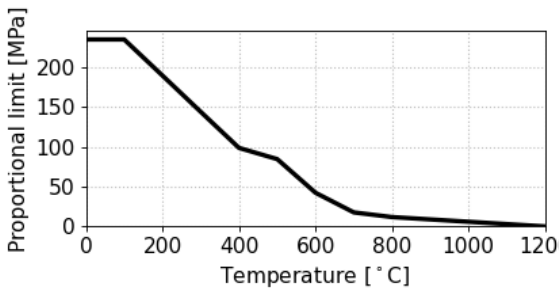
Figure 17. Proportional limit of steel, given by EC3.